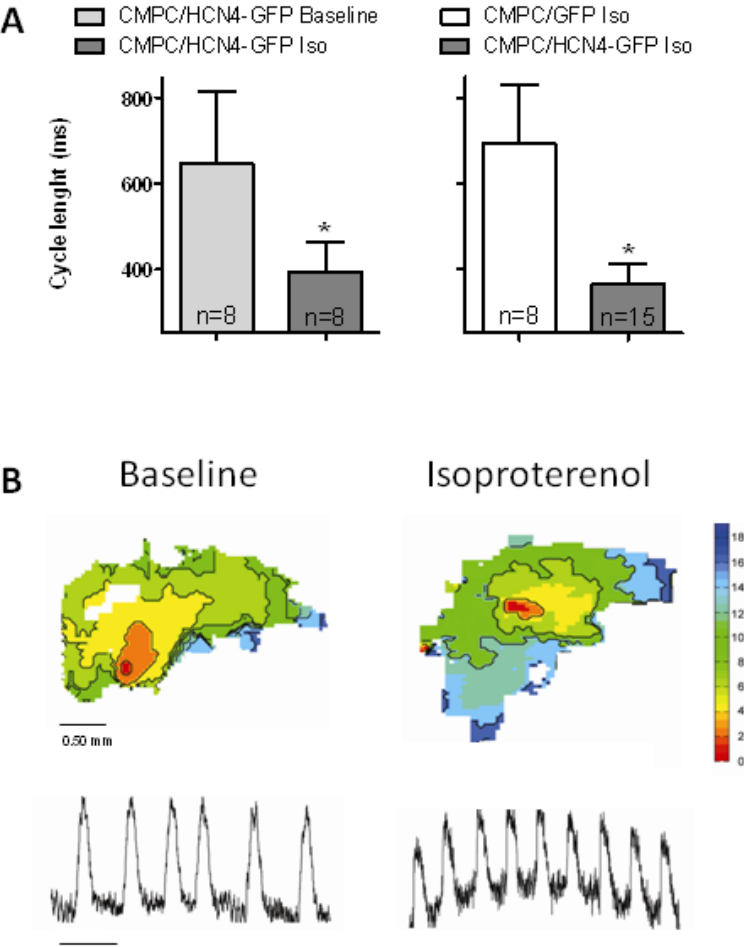
Figure 6. Autonomic modulation of pacemaker function in explants injected with CMPC/HCN4-GFP cells. ( A ) Isoproterenol (10 nM) significantly shortens cycle lengths in explants injected with CMPC/HCN4-GFP (left panel). In the presence of isoproterenol, cycle lengths are significantly shorter in explants injected with CMPC/HCN4-GFP than in CMPC/GFP-injected explants (right panel). ( B ) Typical activation maps and optical action potentials in CMPC/HCN4-GFP-injected explants at baseline and during superfusion with isoproterenol (two different preparations). * indicates P < 0.05.